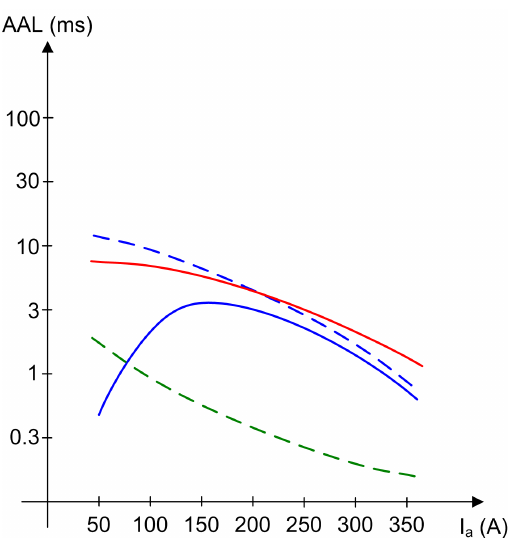
Figure 6. Average arc lifetime for different types of electrodes and arc current values. Hollow-cratered electrode: 200V supply ( blue ) with 10cm inter-electrode distance (solid) and shorter (about 1cm to 2cm, dashed); 400V supply ( red ) with 10cm inter-electrode distance (solid). Pointed electrode ( green ) at 1cm inter-electrode distance